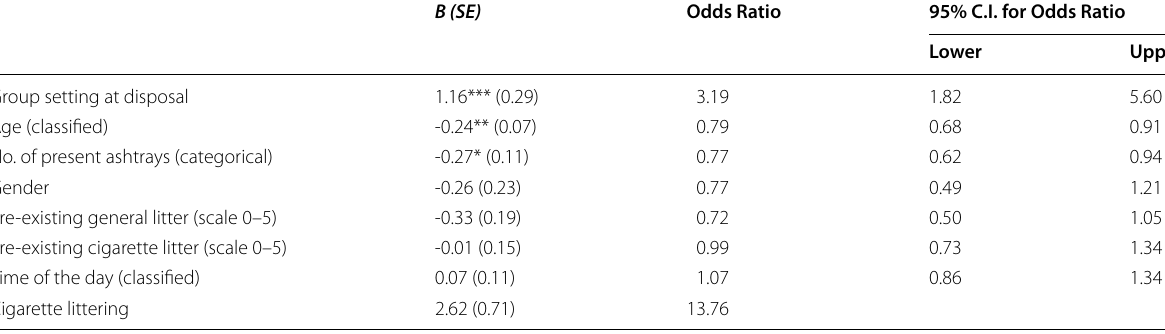
Note . R 2 0.08 (Hosmer–Lemeshow), 0.08 (Cox-Snell), 0.13 (Nagelkerke). Model χ 2 (7) = For each predictor variable, the unstandardized regression coefficient ( B -value) is shown including its standard error. P -values are shown as evidence measure for predictor variables that have an influence on cigarette littering with p < 0.05 for (*), p < 0.01 for (**), and p < 0.001 for (***). Moreover, the odds ratio and its